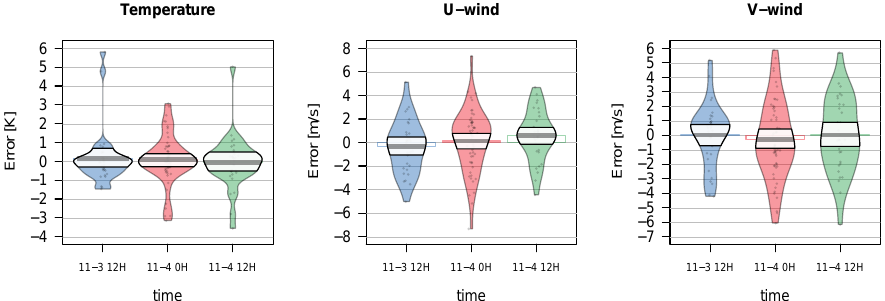
Figure 21. The pirateplots of the errors of three timestamps interpolated using Kriging with the GFS data as input evaluated by the balloons